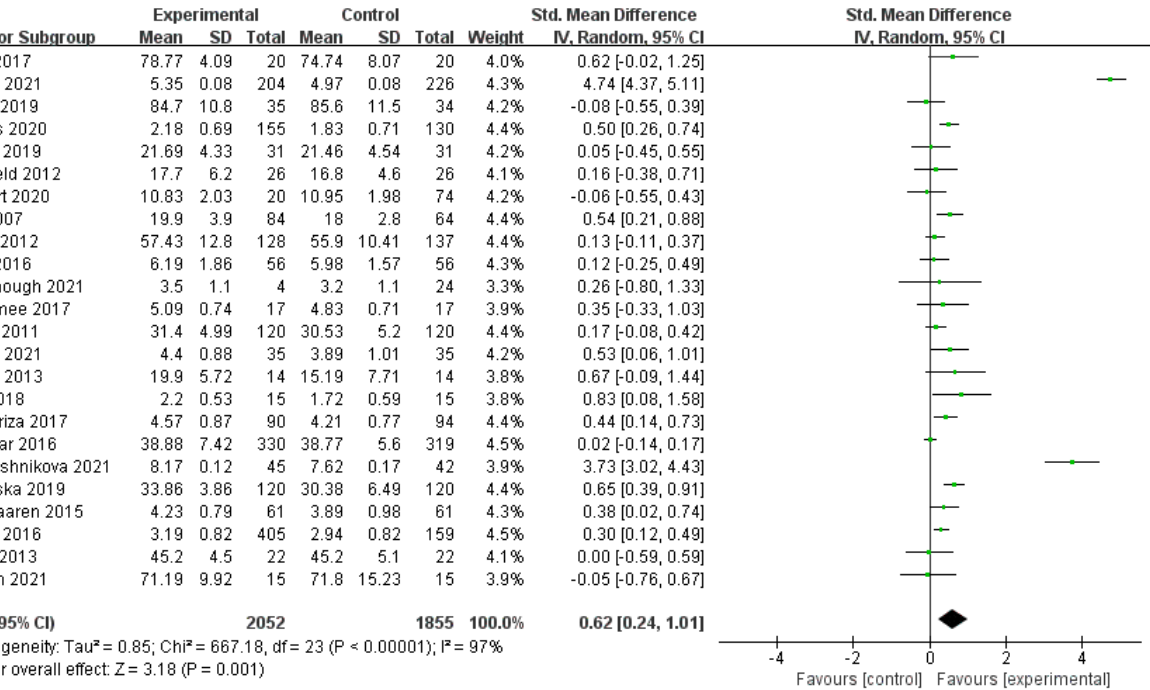
Figure 2. Forest plot of the association between PA and positive emotions in children and adoles- cents [30 – 53].